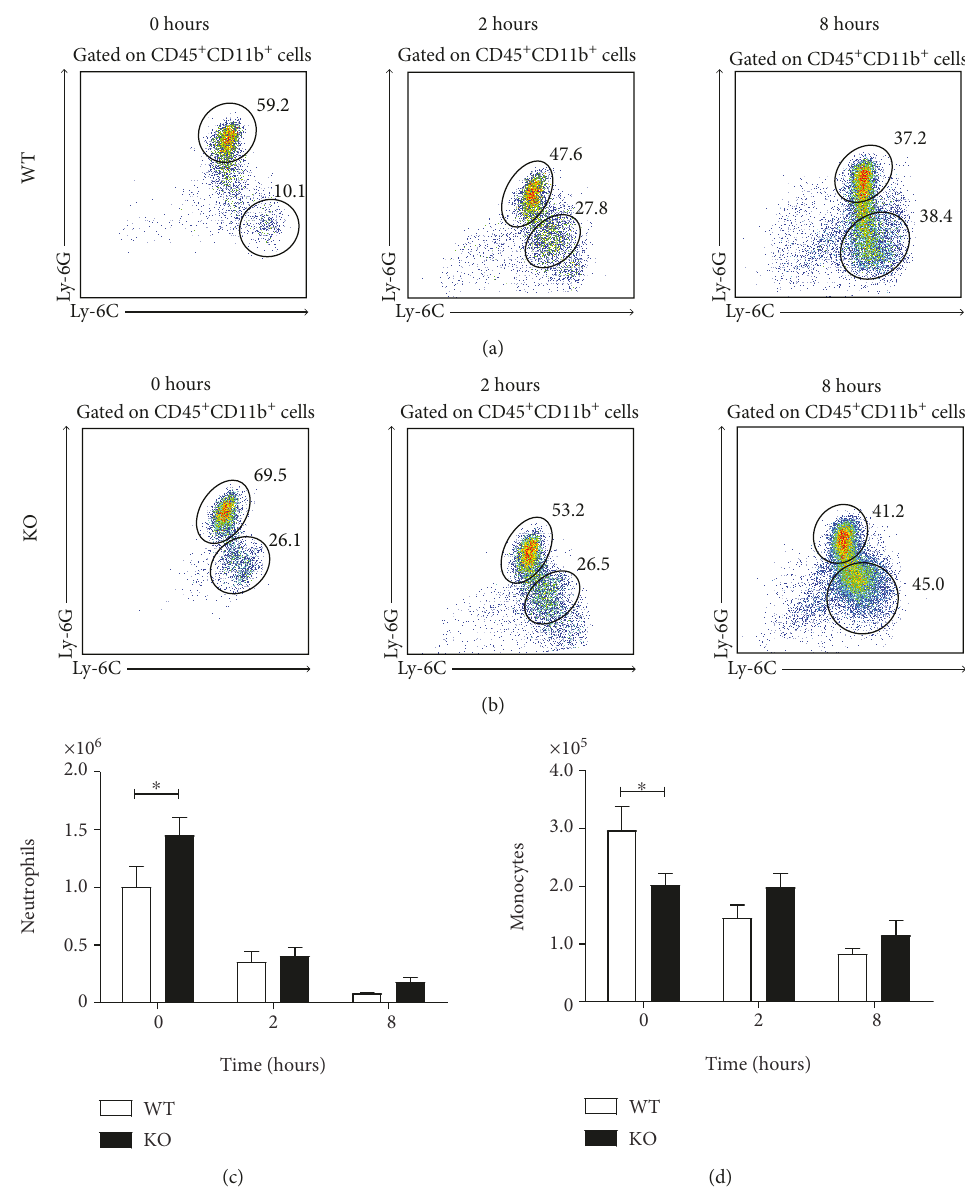
Figure 5: CB knockout mice display elevated neutrophils and monocytes in the bone marrow compared to littermate controls. Male C57BL/ 2 knockout mice (8 – 10 weeks old) were administered i.p. with 1mg/kg LPS and innate immune cell population numbers in the bone 6J and CB 2 marrow were assessed for up to 8 hours. Flushed bone marrow cells from the animal femora were stained for neutrophils (CD45 + CD11b + Ly- 6G hi Ly-6C + ) and monocytes (CD45 + CD11b + Ly-6G mid Ly-6C + ) by fl ow cytometry. Representative dot plot graphs from one C57BL/6J (a) and CB knockout (b) mouse gated on CD45 + CD11b + cells are shown for the full time course. Pooled data from two independent experiments 2 with 7 – 10 mice per group and 3 – 5 mice per group per experiment are shown for neutrophils (c) and monocytes (d). Mean+ SEM are represented in all bar graphs and data were analysed with a two-way ANOVA with Sidak ’ s post hoc multiple comparisons test, ∗ p < 0 05